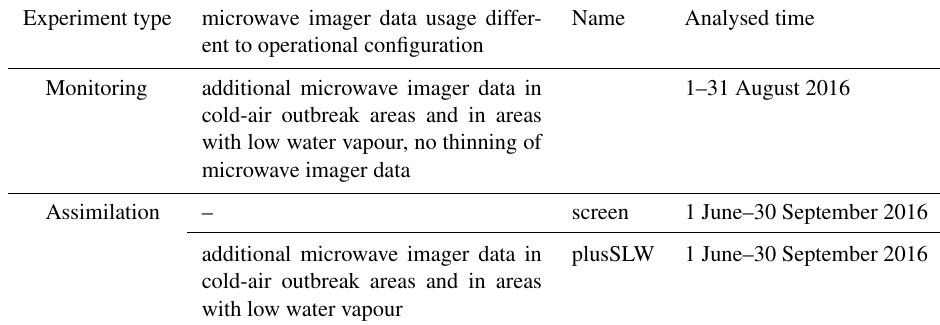
Table 2. List of different experiment set-ups and their details, which have been run using different liquid water permittivity